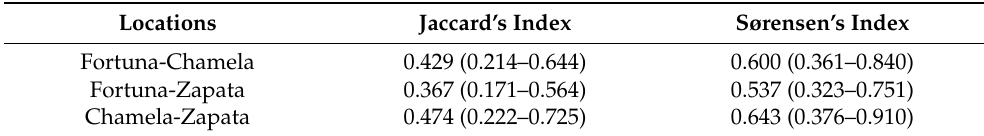
Table 3. Bat species composition similarity by location between two post-hurricane years (2016 vs. 2017) and CI (95%).